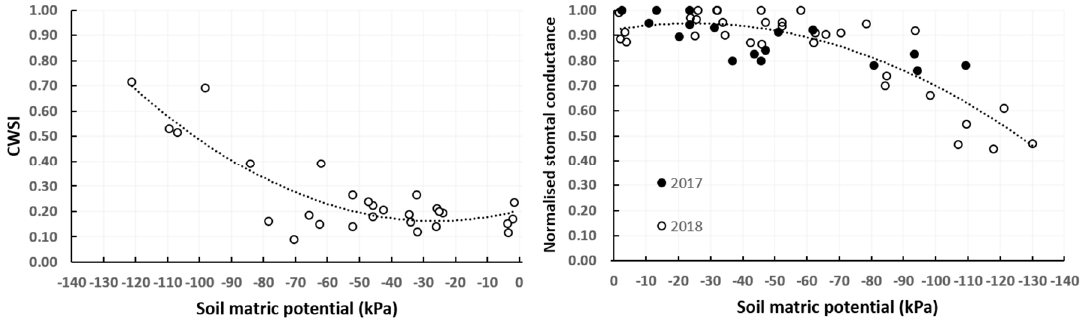
Figure 7. Soil matric potential relationships with CWSI (left; data only for 2018, r 2 = 0.74) and normalised stomatal conductance (right; r 2 = 0.73).